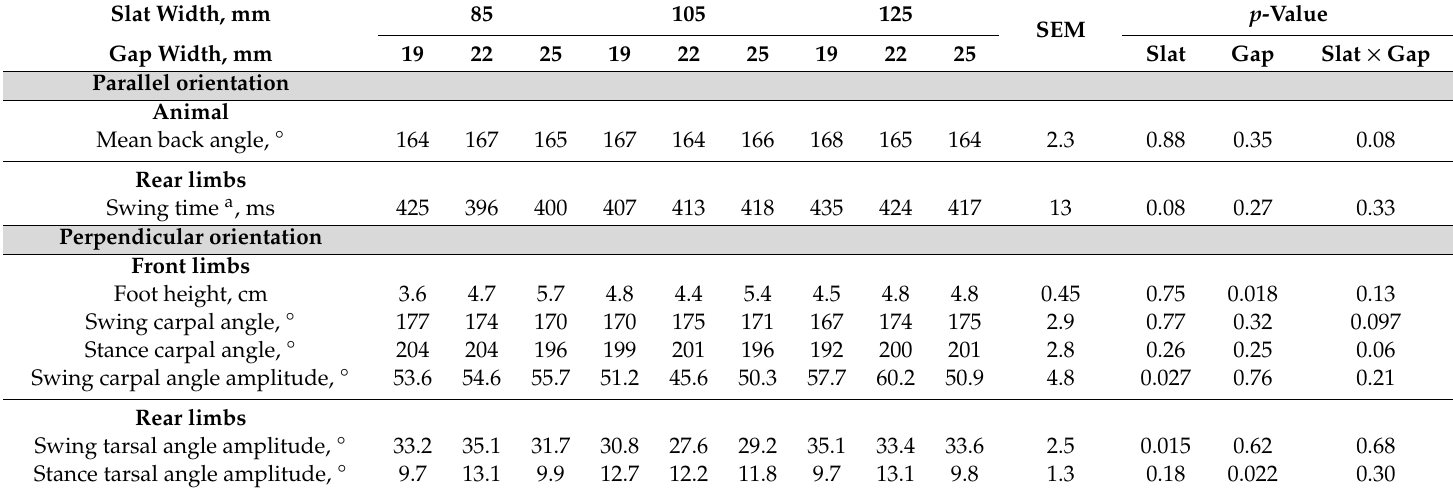
Table 5. E ff ects of slat and gap widths on the gait on lame sows walking on concrete slats with parallel or perpendicular